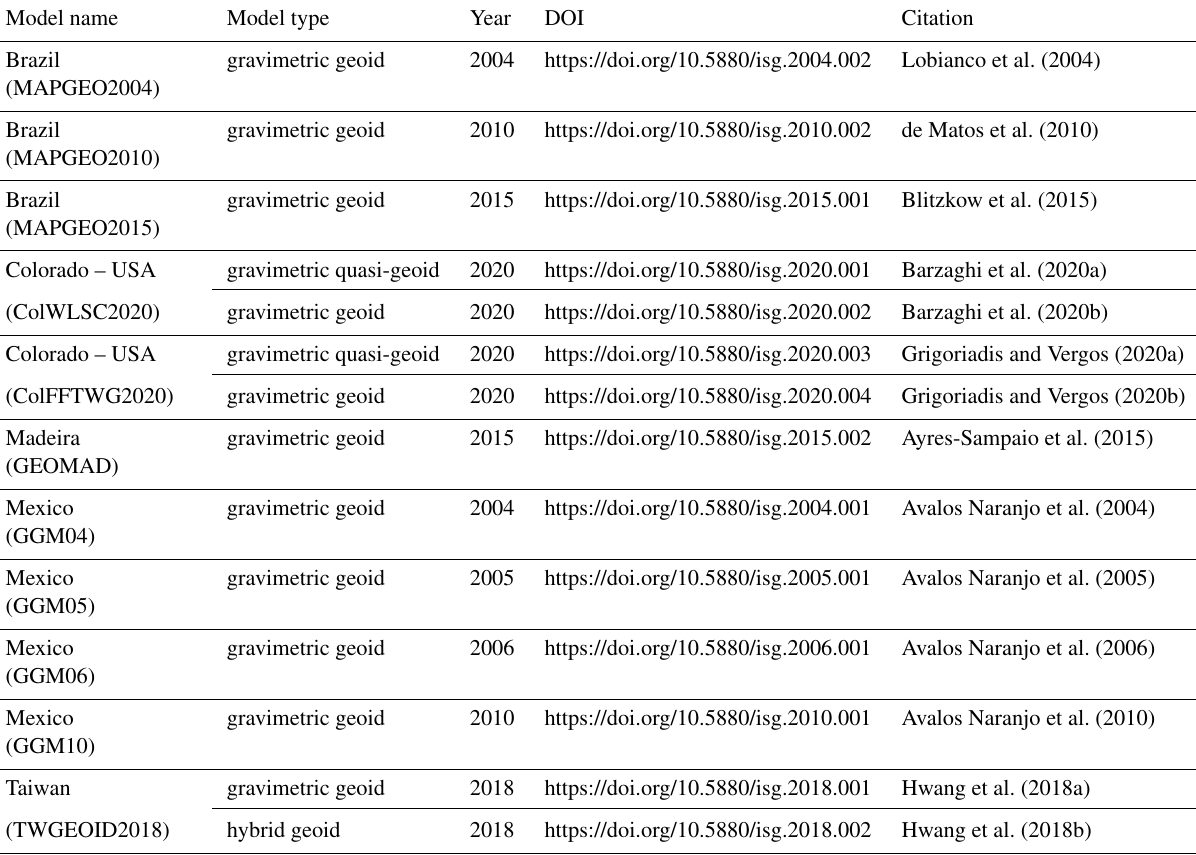
Table A1. Overview of ISG geoid models that have already been labelled with DOIs (as of 31 March